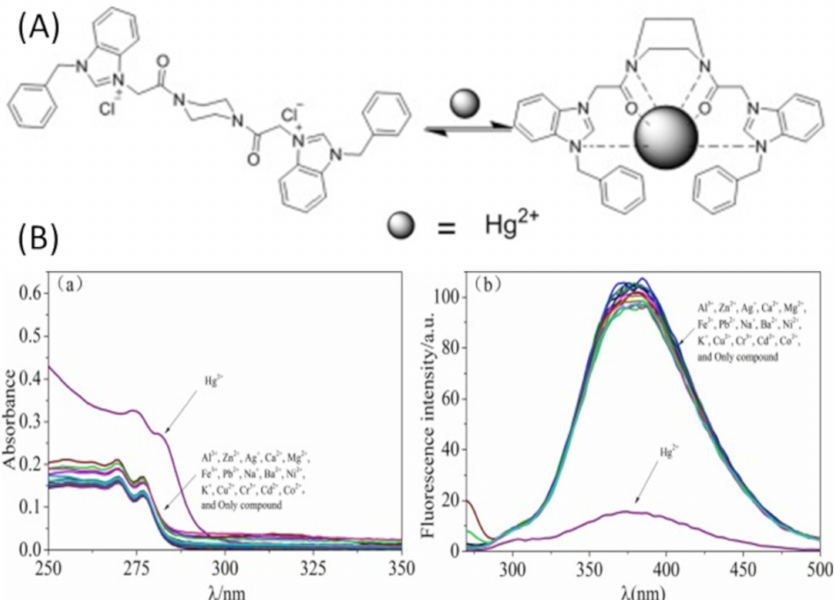
Figure 6. ( A ) Coordination mode of 5 with Hg 2+ , and ( B ) the UV absorption ( a ) and fluorescence ( b ) spectra of sensor 5 (10 µ M) in CH 3 CN/H 2 O (1:1, v / v , pH = 7.4) upon the addition of different cations. Reproduced with permission from [36].